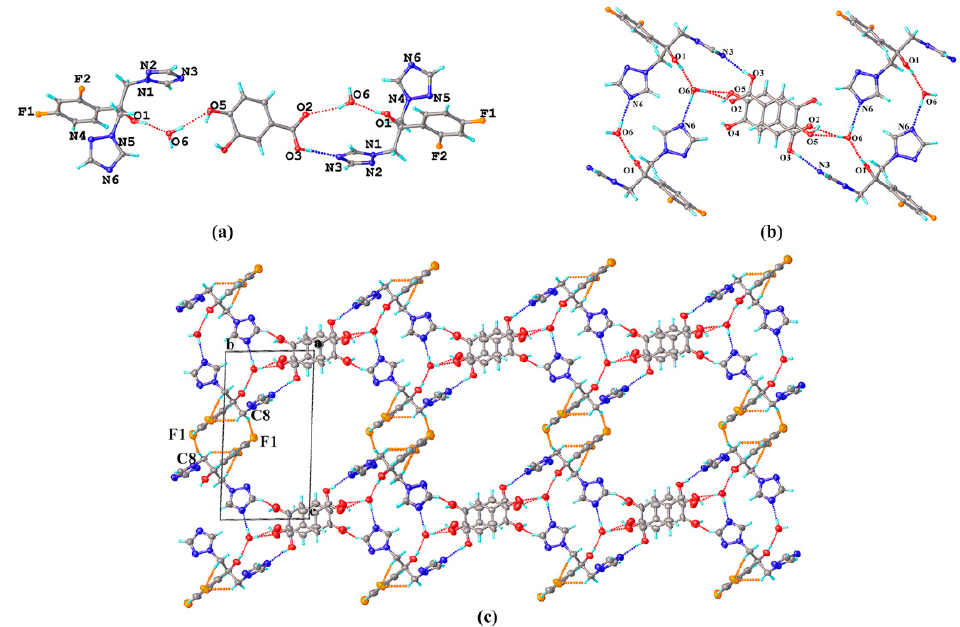
Figure 3. ( a ) Hydrogen-bonding interactions in two asymmetric units; ( b ) the centrosymmetric